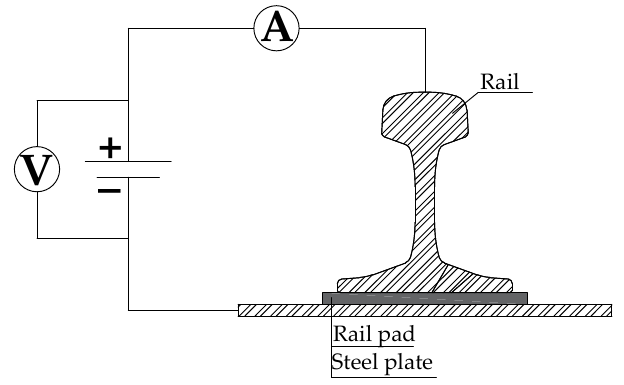
Figure 15. Measuring the electrical resistance of the elastic pad.